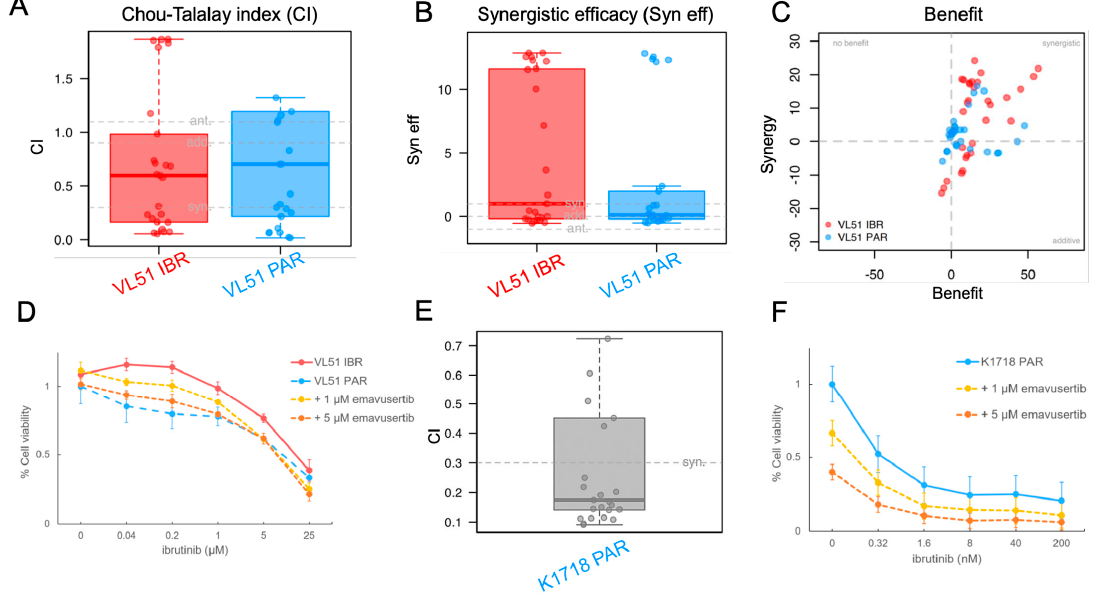
Figure 2. IRAK4 inhibitor emavusertib in Karpas1718 parental (K1718) and VL51 parental (PAR) and ibrutinib-resistant line (IBR). Cells were exposed (72 h) to increasing doses of ibrutinib alone or